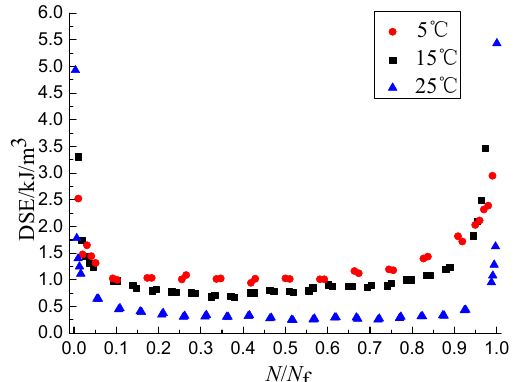
Figure 4. The influence of temperature on DSE.